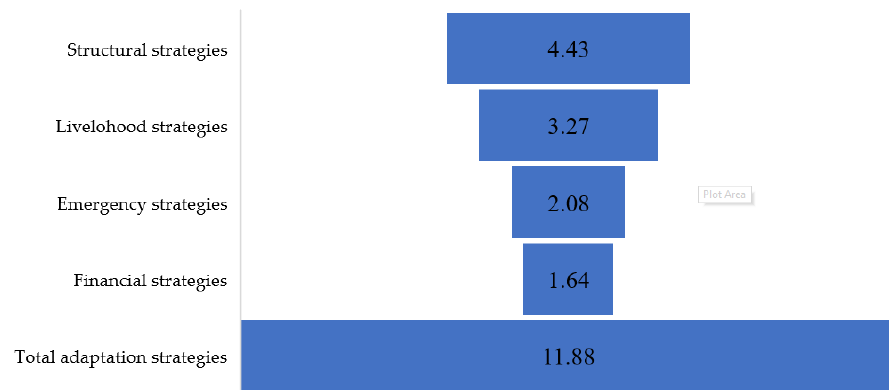
Figure 3. Mean of different flood adaptation strategies.